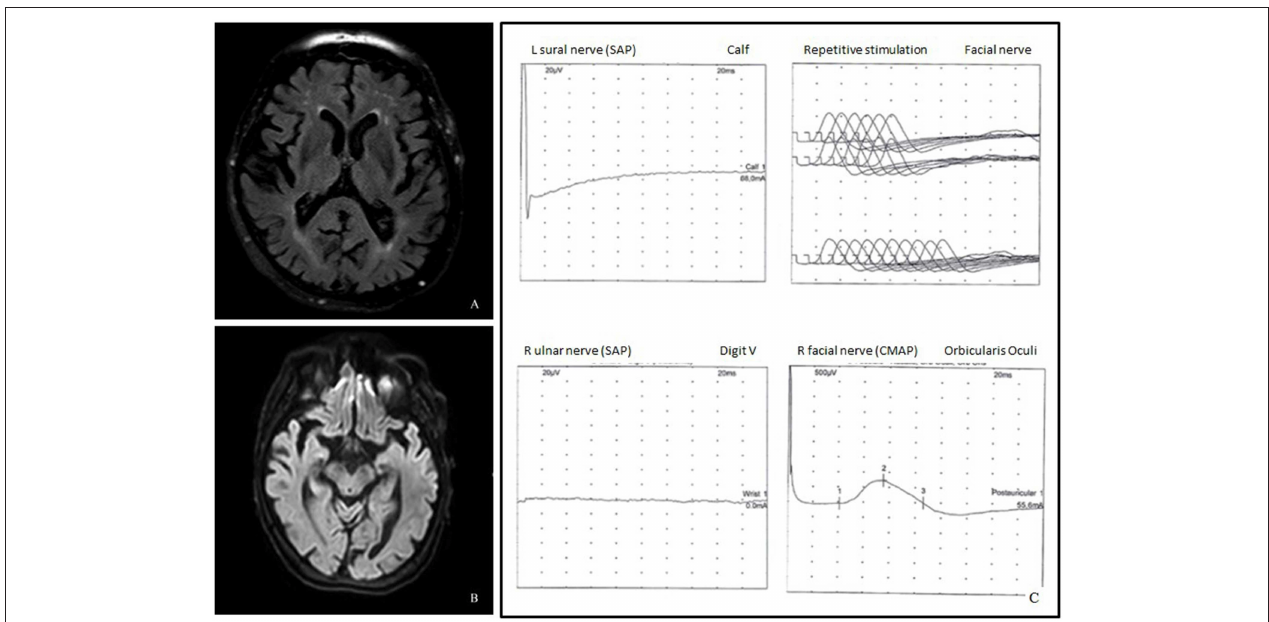
FIGURE 1 | (A) Axial fluid attenuated inversion recovery (FLAIR) image demonstrated cortico-subcortical atrophy and chronic cerebrovasculopathy. (B) Diffusion weighted imaging (DWI) did not show acute lesions. (C) Neurophysiological studies showed absence of the left sural and the right ulnar sensory nerve action potentials, mildly increased latency of the facial nerve CMAP, and normal repetitive facial nerve stimulation.